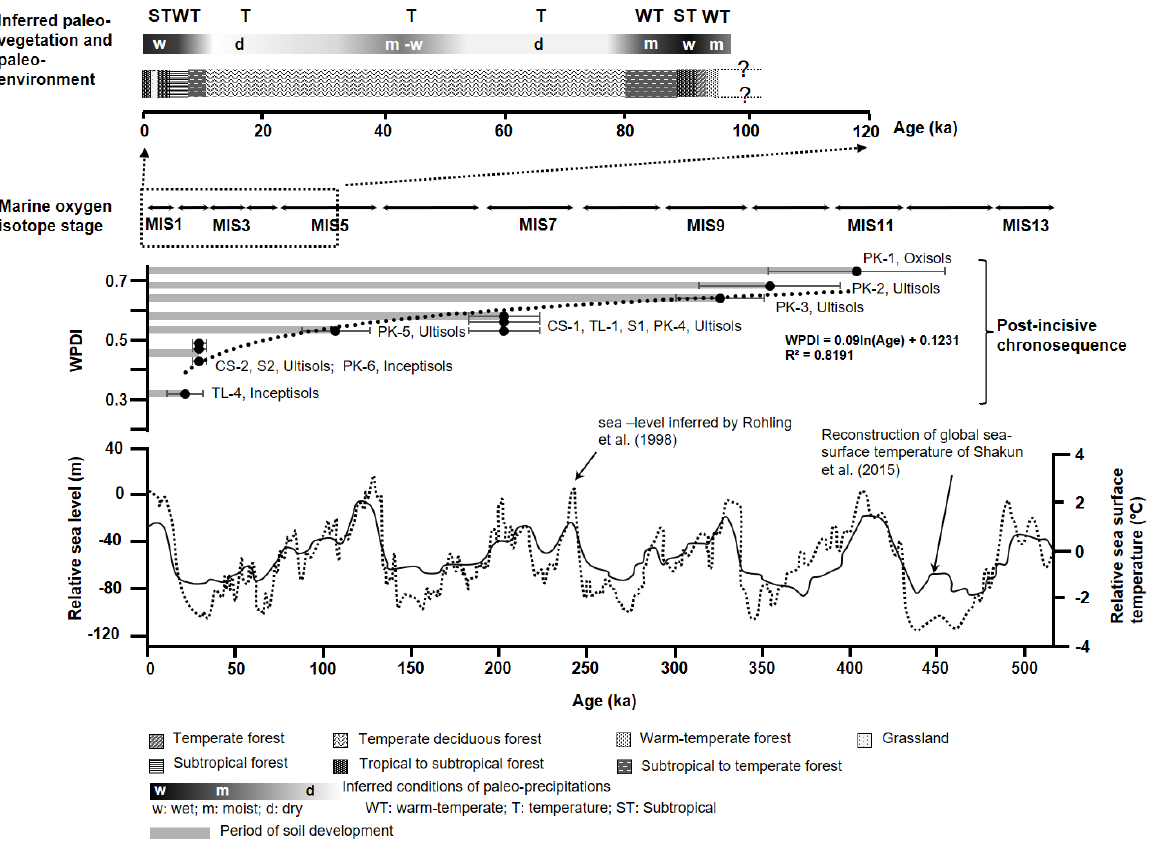
Figure 7. Conceptual schematic diagram of soil pedogenesis related to paleoclimatic variations since MIS 11. Global mean sea level shifts were inferred by Rohling et al. [64]. Reconstruction of global mean sea-surface temperature was suggested by Shakun et al. [65]. Inferred conditions of paleovegetation and paleoenvironment were proposed by Liew et al. [32], which based on a pollen record from peat sediments in central Taiwan. WPDI values of PK − 1~PK6, CS − 1, CS − 2, TL − 1, and TL4 were calculated by Tsai et al. [23].